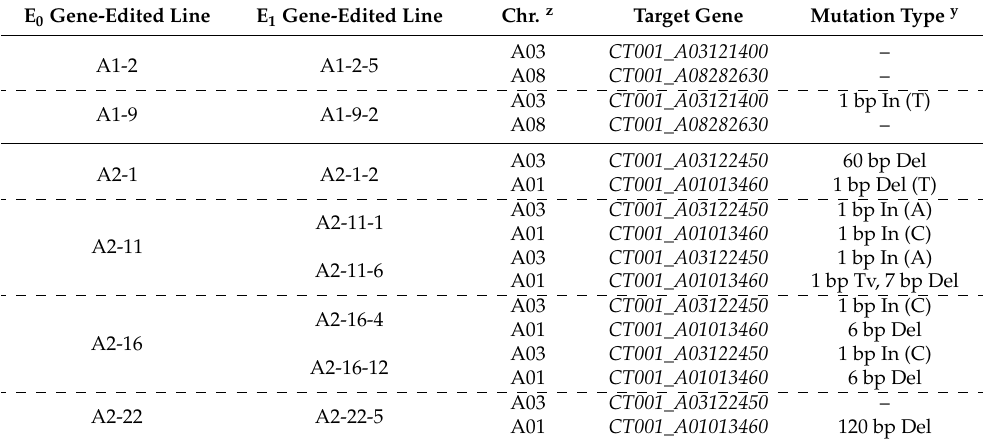
Figure 6. Analysis of T-DNA copy number and insertion position in E 0 AGAMOUS-like (AGL) -edited lines. ( A ) Southern hybridization analysis for identifying the copy number of T-DNA in the E 0 AGL -edited lines’ genome. Briefly, 30 µ g of genomic DNA was digested with Eco RI, separated, and blotted onto Hybond N + nylon membranes for hybridization with a [ 32 P]-labeled probe. The approximate DNA molecular size marker is indicated on the left. M, λ Hin dIII molecular ladder; N, negative control; lane, E 0 AGL -edited lines showing late bolting and sequence mutations. ( B ) A modified variable argument thermal asymmetric interlaced PCR (VA-TAIL PCR) analysis to confirm the flanking DNA sequence of T-DNA in the E 0 AGL -edited lines’ genome. Arbitrary degenerate (AD) primers and T-DNA border-specific primers were designed and amplified using 100 ng of genomic DNA as a template. M, 100 bp DNA ladder; lane, E 0 AGL -edited lines. ( C ) Schematic diagram of the T-DNA insertion site in the E 0 AGL -edited lines’ genome. T-DNA was inserted into the intergenic region of the genome of the E 0 AGL -edited lines. Table 1. Mutagenesis patterns in T-DNA-free E 1 AGL -edited